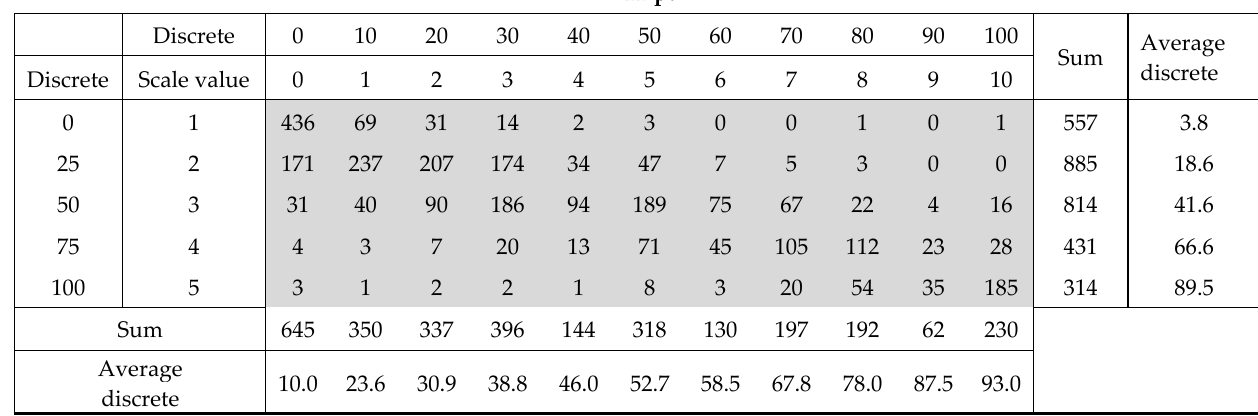
Table 9. Frequency-weighted average of discrete values of the 11-point numerical scale scores on the 5-point verbal scale.